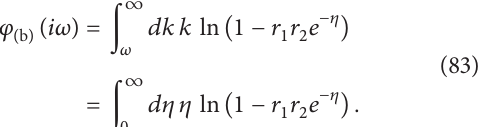
Figure 2. The reflection coefficients entering the second